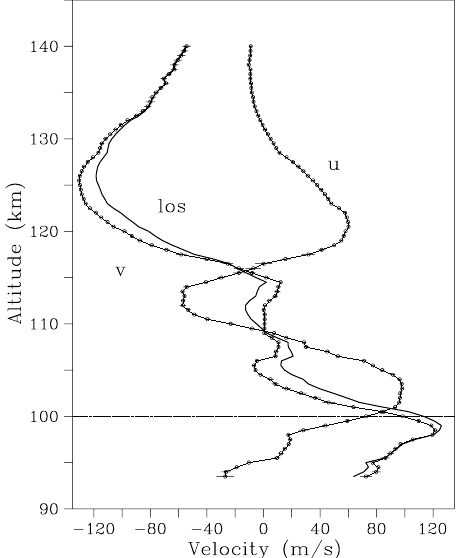
Fig. 4. Neutral winds inferred from the triangulation of TMA trails at 12:31UT during the flight of 36.234. Curves with error bars rep- resent meridional (v) and zonal (u) wind estimates, respectively. Positive values denote northward and eastward winds. The heavy curve without error bars is the wind speed in the direction of the main beam of the 30MHz radar (los), which is pointed toward the Poker Flat range. Positive values imply downrange